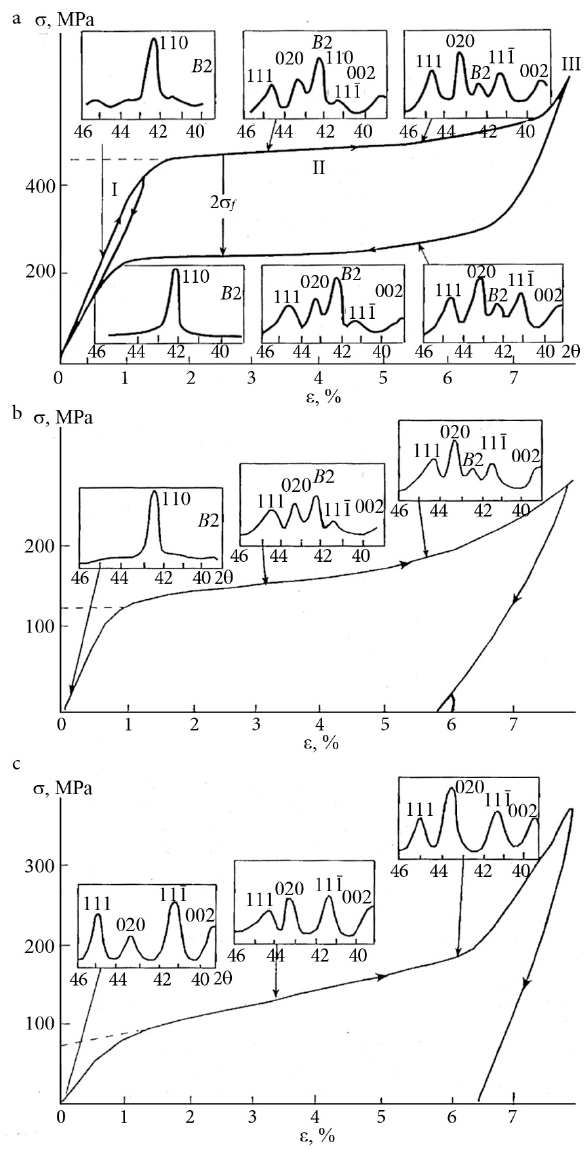
Figure 30. ( a – c ) Accumulation and recovery of deformation in isothermal «loading-unloading» cy- cles at tensile tests of CG Ti 49 Ni 51 alloy ( а ) with complete SEE at near M s , ( b ) with incomplete SEE at near M s , and ( c ) below M s